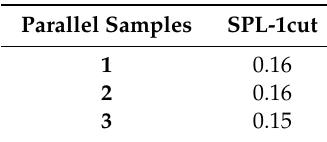
Table 2. Sulfur content of SPL-1cut